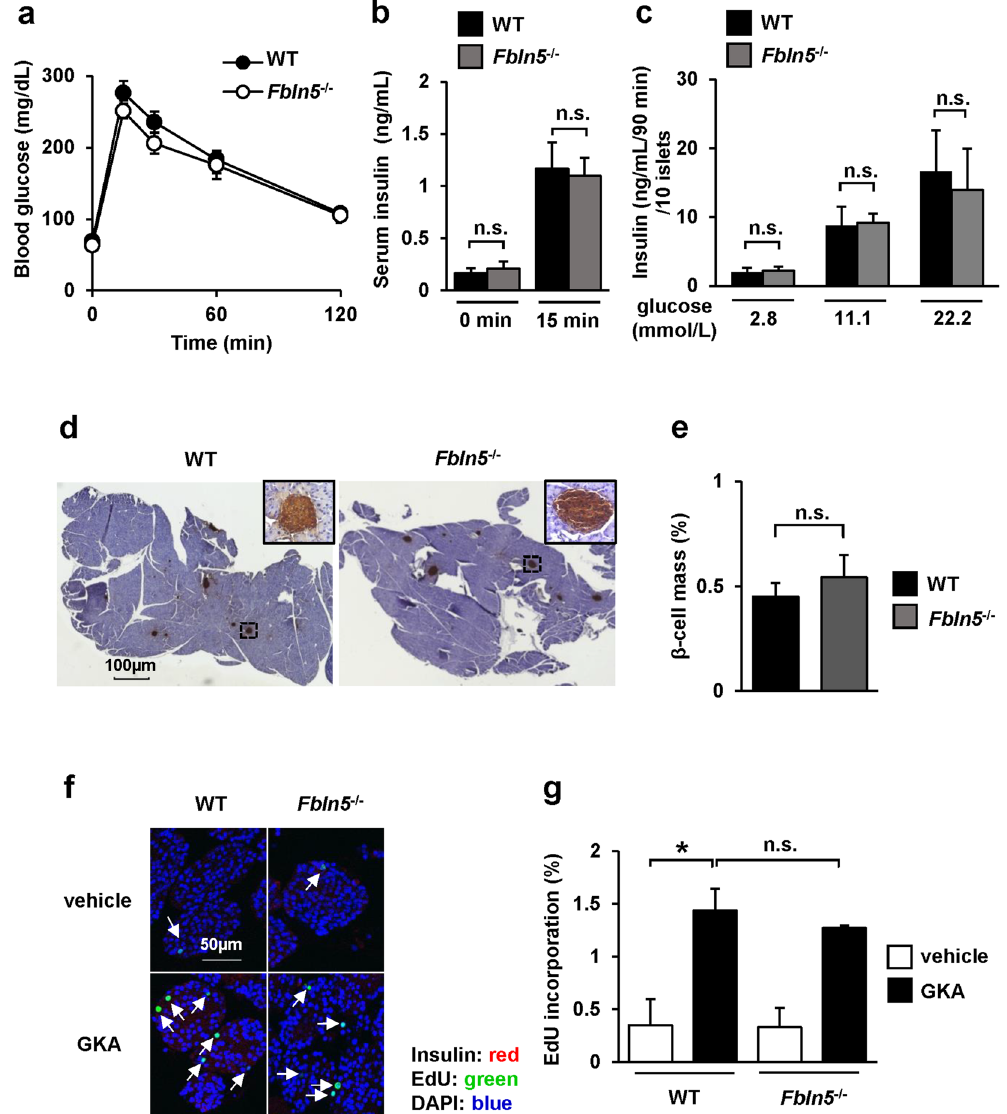
Figure 3. Fbln5 deficiency in mice had no effect on glucose tolerance, glucose-stimulated insulin secretion or β -cell proliferation. ( a ) Blood glucose levels during an oral glucose tolerance test (OGTT) in 8-week-old Fbln5 − / − mice and wild-type mice (1.5 g/kg body weight, n = 11–13). ( b ) Serum insulin levels during the OGTT (n = 11–13). ( c ) Glucose-stimulated insulin secretion in ten isolated islets from 8-week-old Fbln5 − / − mice and wild-type mice (n = 6–12). ( d , e ) β -cell mass in 8-week-old Fbln5 − / − mice and wild-type mice (n = 5). Representative images of the pancreas showing brown staining of insulin ( d ) and the ratio of the β -cell mass relative to the area of the whole pancreas ( e ) (n = 5). The scale bar represents 100 µ m in the pancreas images. ( f , g ) EdU incorporation in islets isolated from 8-week-old C57BL/6 J mice. Representative images of pancreatic islets after 48 hours of incubation with EdU in the presence or absence of 30 μ mol/L of GKA CpdA ( f ). Insulin is stained red, nuclei are stained blue with 4 ′ , 6-diamidino-2-phenylindole [DAPI], and EdU-positive nuclei are stained green. The white arrows indicate EdU-positive β -cells. The scale bar represents 50 µ m. The ratio of EdU- positive β -cells to the total count of insulin-positive β -cells is shown ( g ). More than 3000 cells were counted in each group (n = 2). Data are represented as means ± SEM. * p <